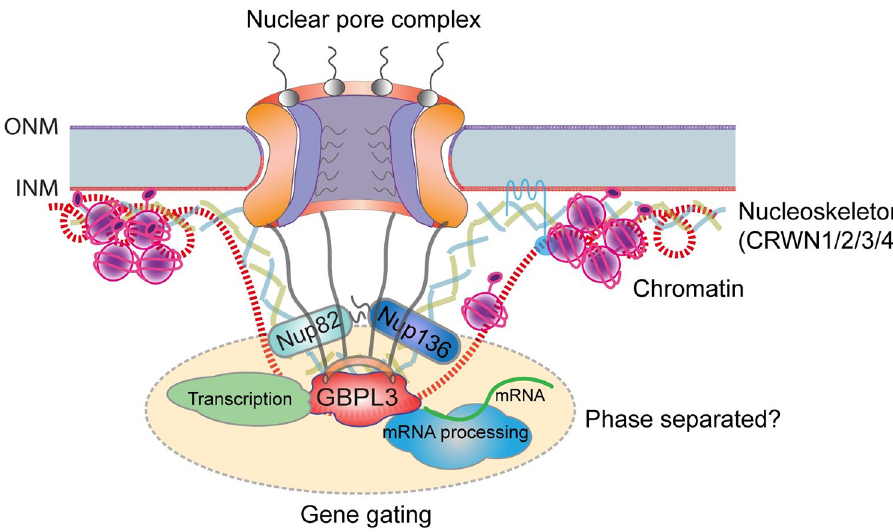
Fig 6. Function of GBPL3 at the nuclear basket. GBPL3 resides at a distal region of the NB away from the NPC core and associates with basket nucleoporin Nup82 and nucleoskeleton component CRWN proteins. GBPL3 may collaborate with different CRWNs to differentially regulate developmental and stress-related gene expression. GBPL3 is capable of recruiting chromatin remodelers, core transcription apparatus, TFs, and the mRNA splicing and processing machinery, and may regulate gene gating at the NPC. Molecular interactions centered at GBPL3 at the NB are possibly promoted by a phase separation process. INM, inner nuclear membrane; NB, nuclear basket; NPC, nuclear pore complex; ONM, outer nuclear membrane; TF, transcription